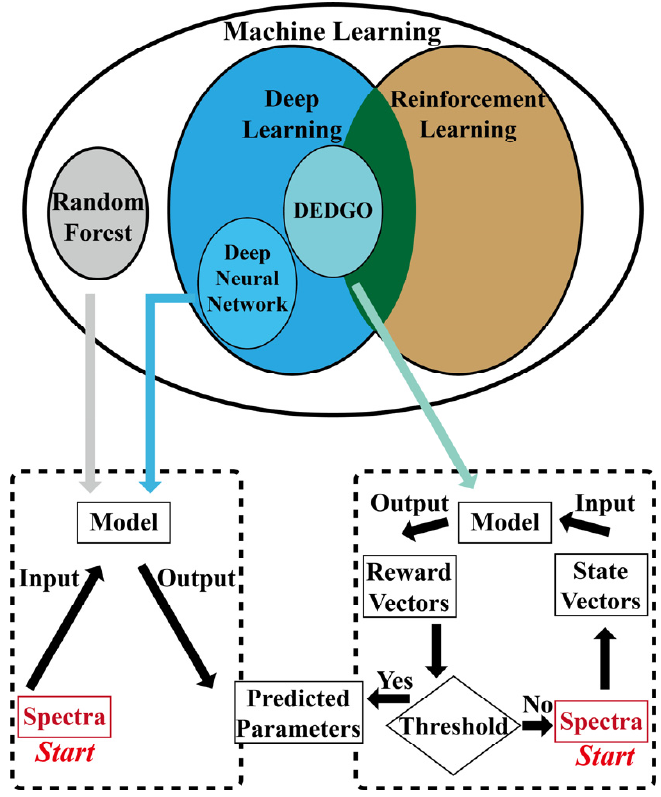
Figure 1. Principles and operating modes of different algorithms. The ellipses show their principles, and the boxes reveal their operating modes, direct prediction (the left box), and iterative optimization (the right box).